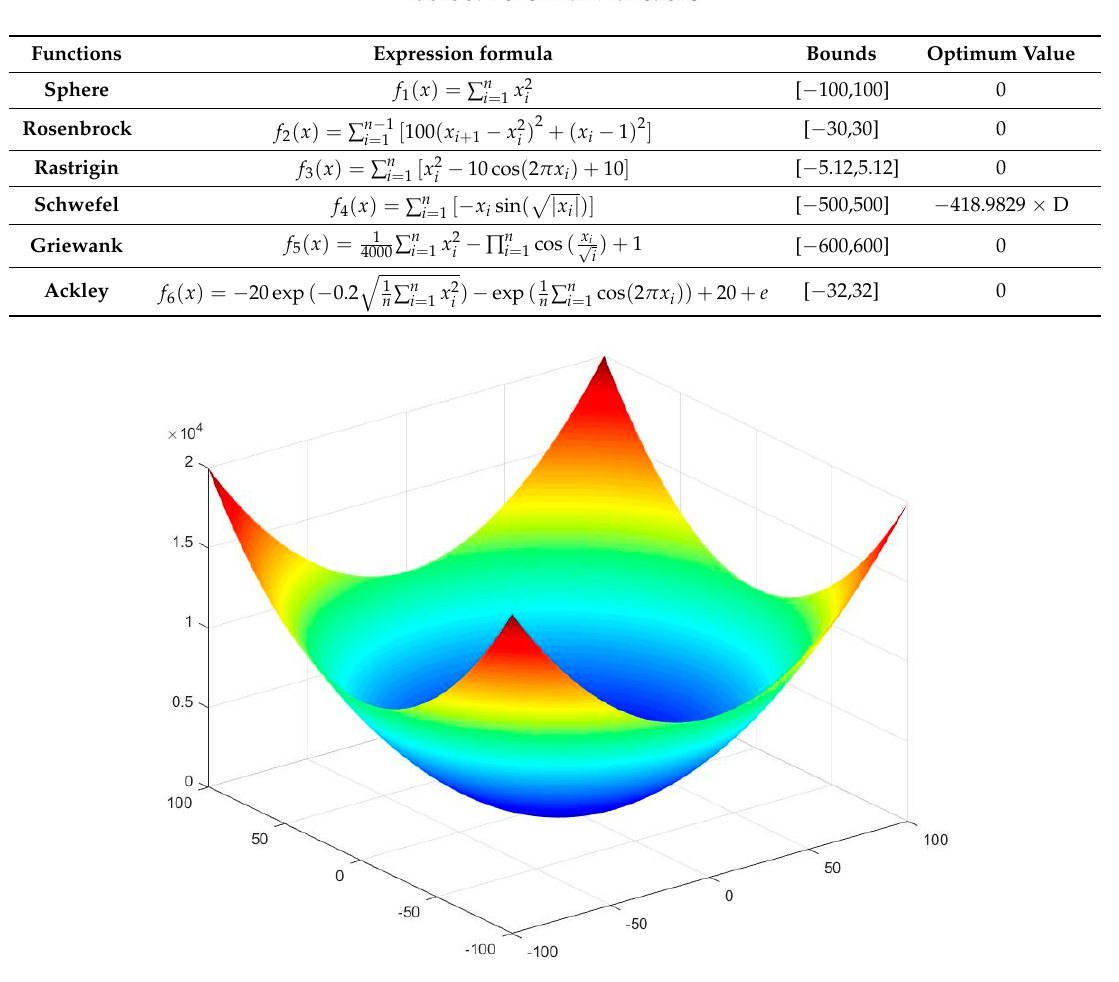
Figure 3. Three-dimensional image of Sphere function ( f 1 ).